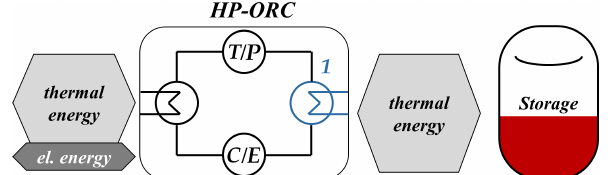
Figure 1. Principle of the reversible heat pump (HP)–organic Rankine cycle (ORC) Carnot battery (with T : throttle valve; P : ORC-pump; C : compressor; E : expander; 1 : upper heat